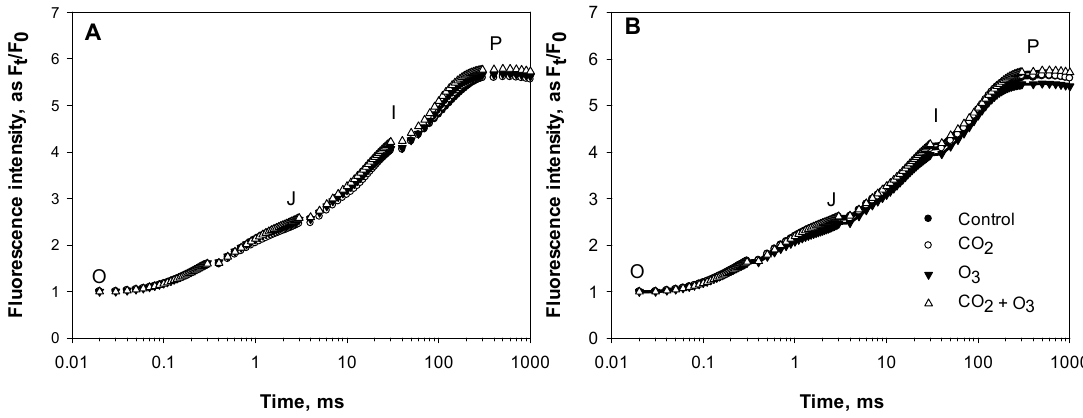
Figure 6. Average (of all weeks) Chl a fluorescence transients of dark-adapted wheat leaves exposed to elevated CO 2 , O 3 and CO 2 +O 3 under well-watered ( A ) and water-stressed ( B ) conditions. A positive Δ K-band shows an increased reduction rate of quinone (Q A ), from Q A to Q A − , which suggests that the oxygen evolving complex (OEC) may have become leaky and offers access to non- water electron donors [32]. Positive Δ L- and Δ K-bands in the O 3 treatment were revealed clearly under both water regimes (Figure